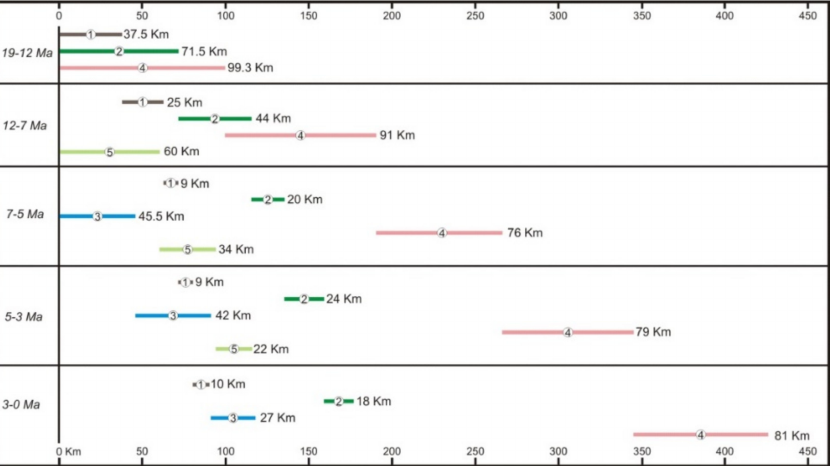
Figure 19. Estimated extension and timing along representative small circle arcs about the Euler poles of sectors 1–5 with respect to Sardinia-Corsica. Brown line ( 1 ): Northern sector, dark green line ( 2 ): Central sector, blue line ( 3 ): Southern sector, pink line ( 4 ): Calabrian arc sector, light green line ( 5 ): Sicilian